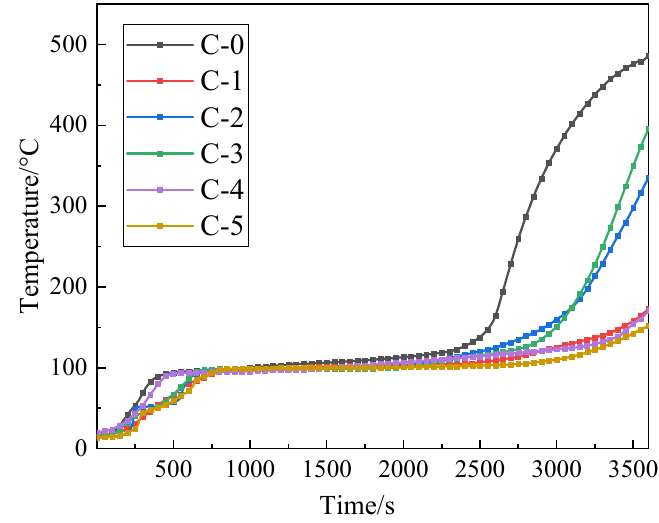
Figure 12. Backside temperature curves of aged samples.